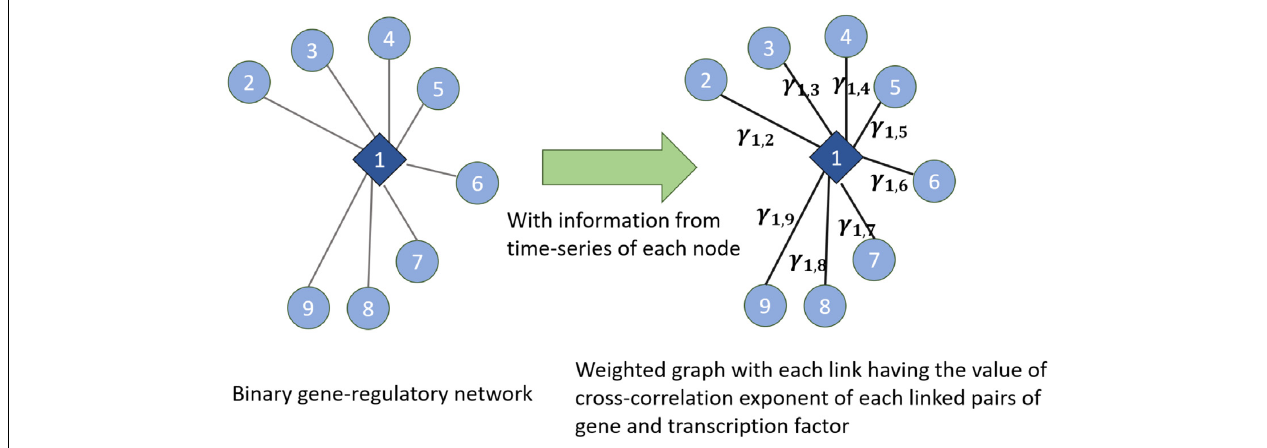
FIGURE 7 | Extracting a weighted graph from cross-correlation exponents of the linked nodes in a gene regulatory network